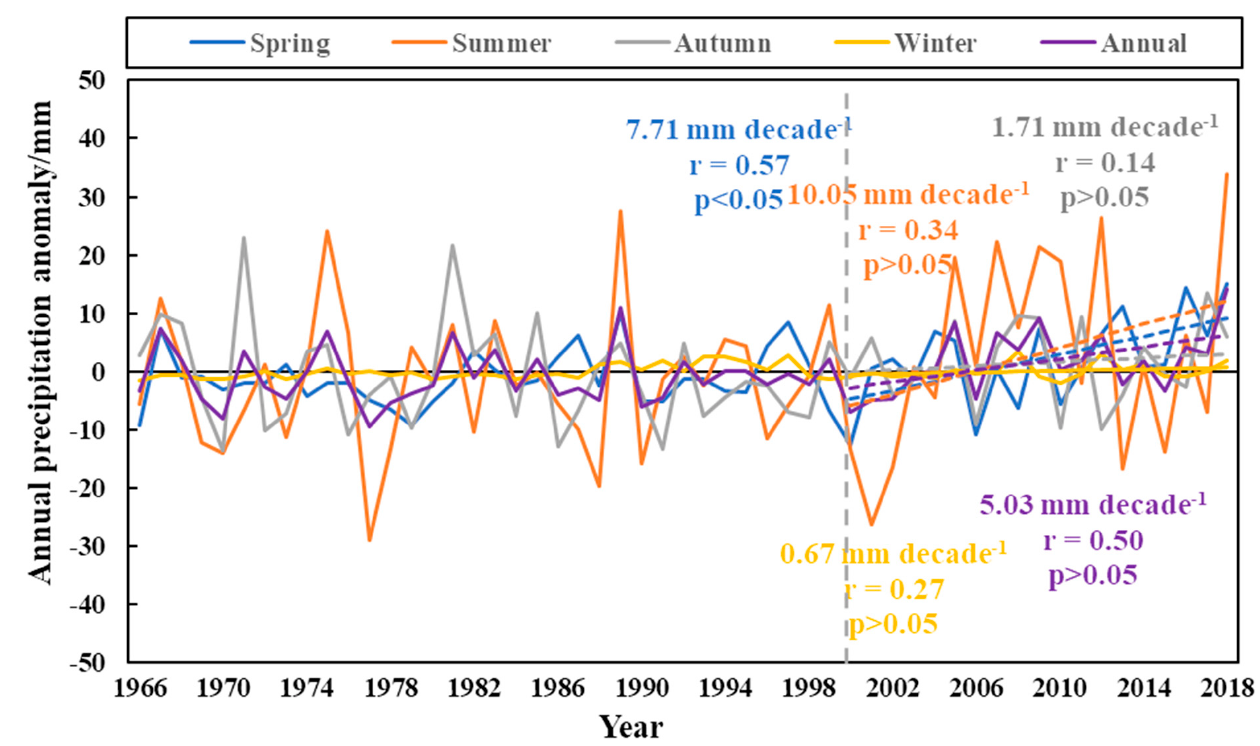
Figure 3. Time series of the spring, summer, autumn, winter, and annual mean precipitation anom- alies from 1966 to 2018.